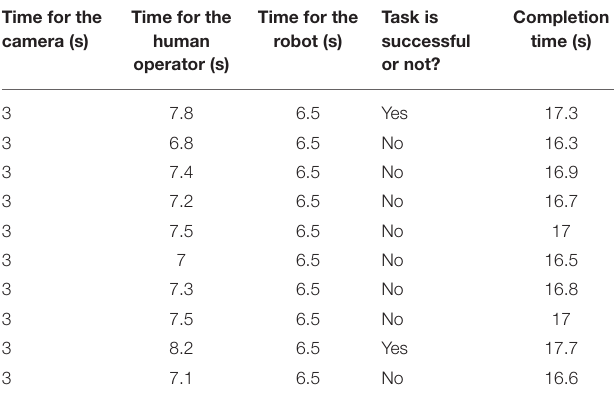
TABLE 1 | Cooperative assembly without cooperative shared